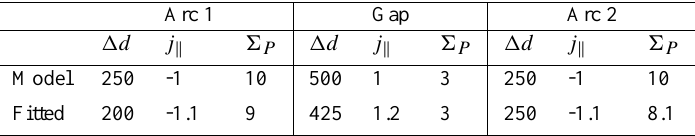
Table 1. Parameters of the arc systems used in the illustrative model (Fig. 4) and the fit to observations (Fig. 5). Parameters indicated